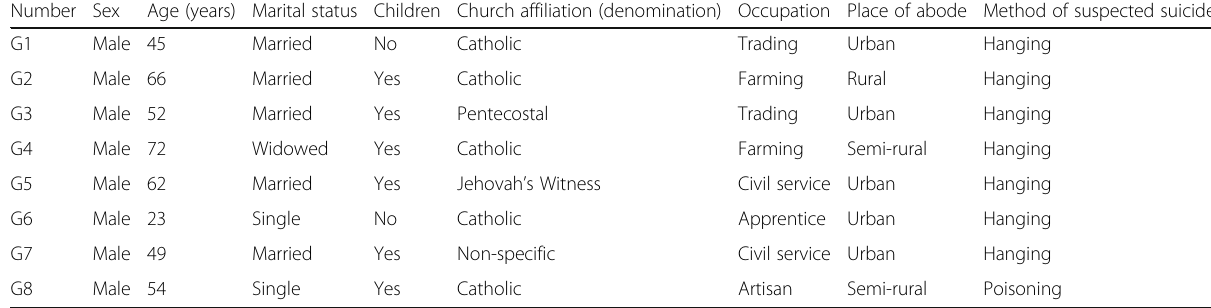
Table 2 Sociodemographic characteristics of the deceased Number